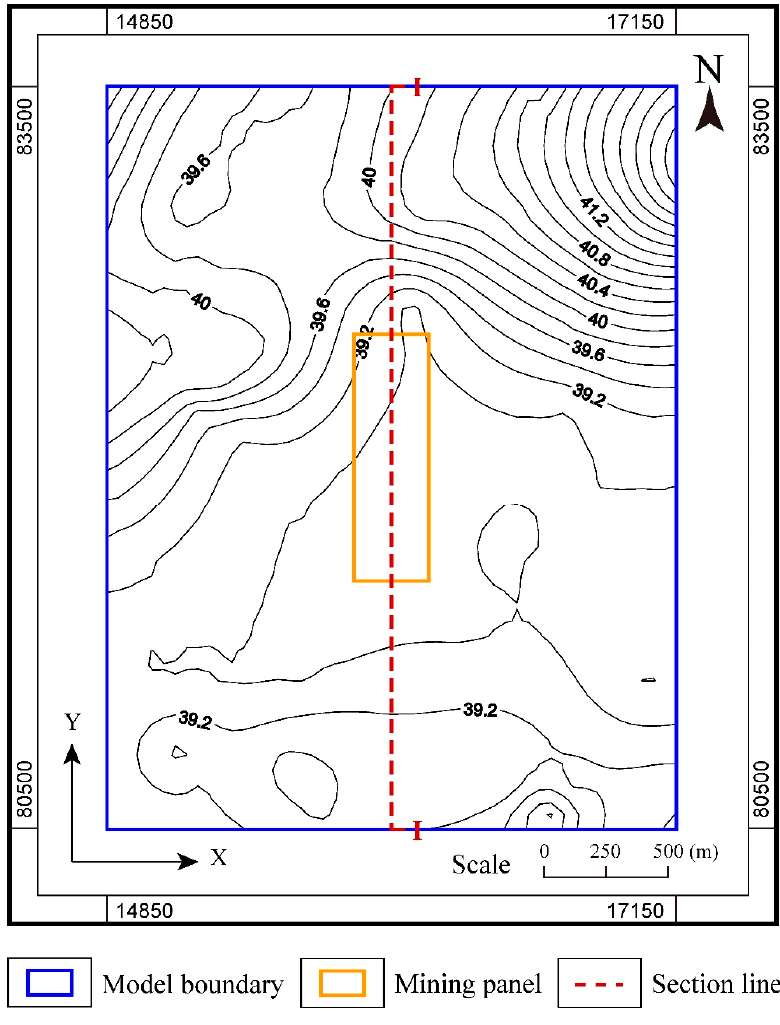
Figure 8. The contour map of the ground surface in the study area.